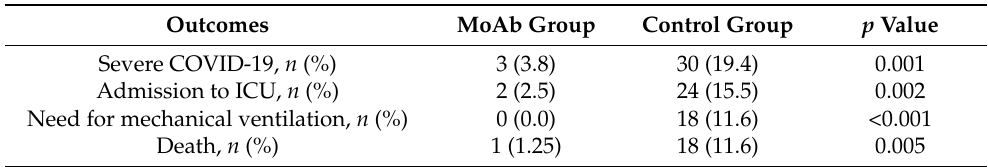
Table 4. Outcomes at 1 month of kidney transplant recipients treated or not with anti-SARS-CoV-2 monoclonal antibodies [80].